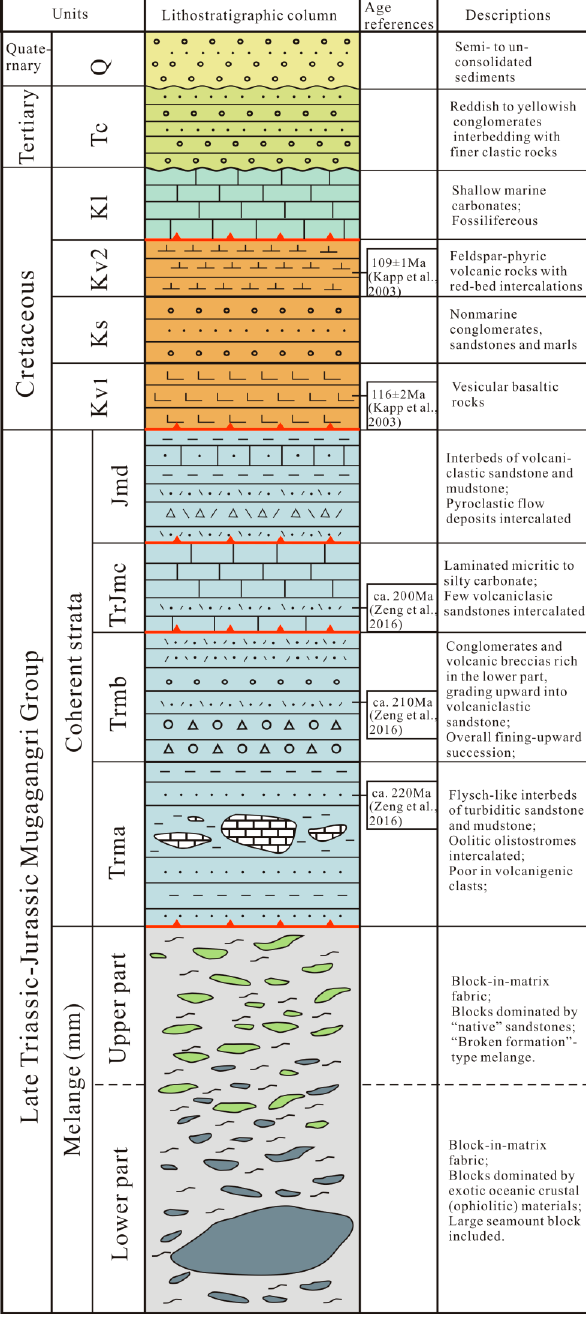
Figure 5. Lithostratigraphic columns of the study area. Internal structure of the Mugagangri Group is revealed: (1) Tectonic mélanges and coherent strata are both essential components; (2) coherent strata are subdivided into four subunits, coded as Tr ma , Tr mb , TrJ mc and J md ; (3) the mélanges are internally stratified with lower part dominated by exotic oceanic materials and upper part by native sedimentary materials. Age data are referred to [11,17]. See text for detailed description.